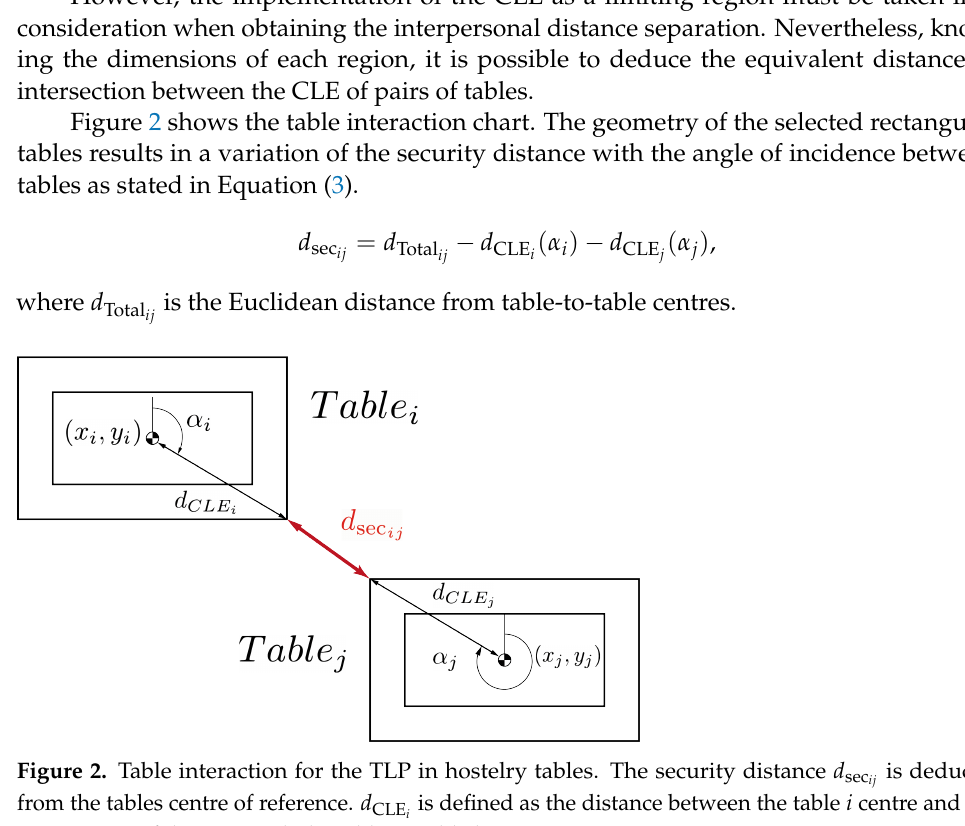
is defined as the distance between the table i centre and the i